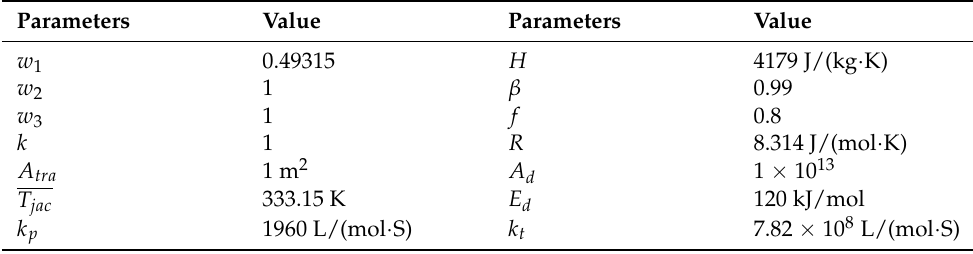
Table 2. Fixed parameters and their